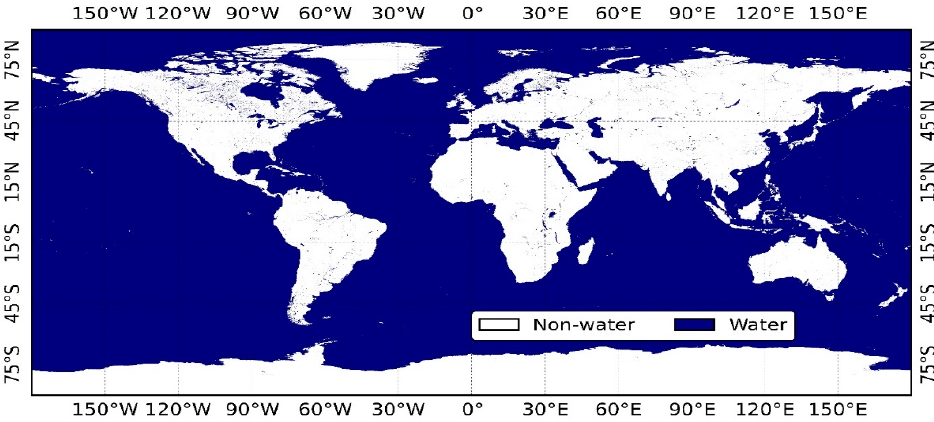
Figure 12. Global water cover map of 2013 produced through the